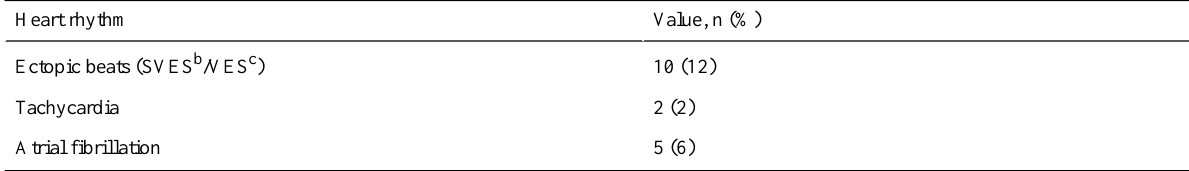
Table 2. Rhythms detected during the study (N=86). a